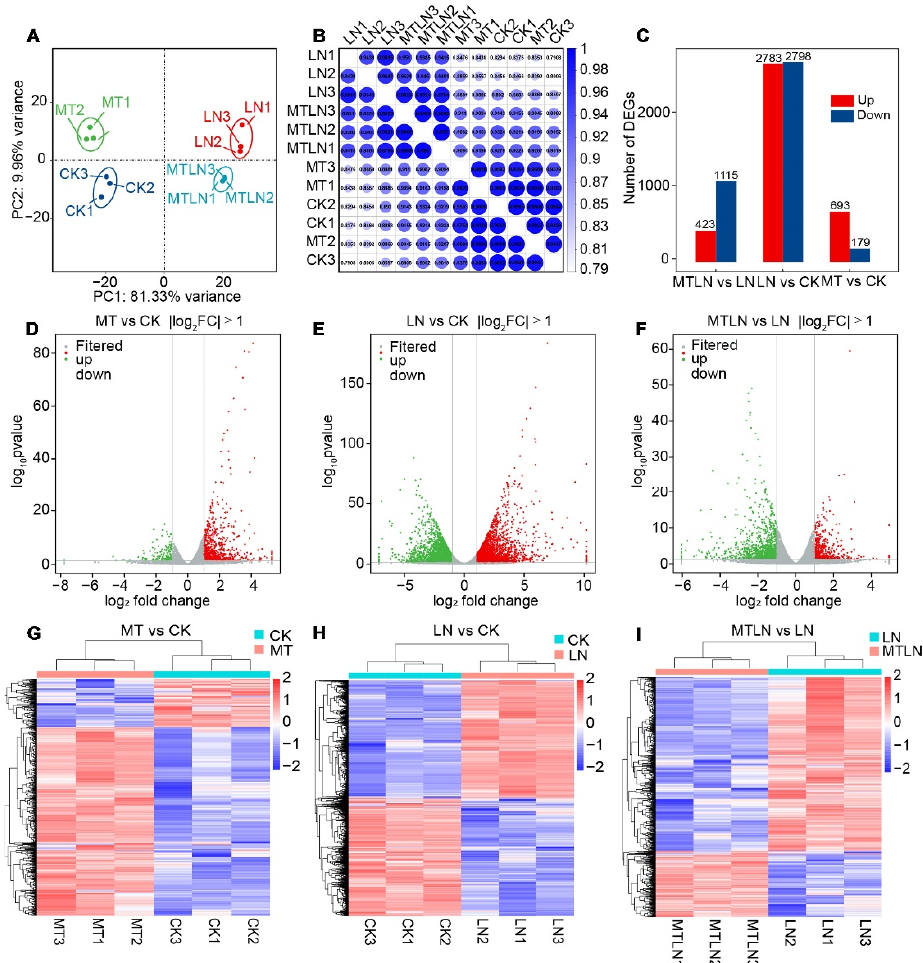
Figure 5. Analysis of differentially expressed genes (DEGs) of melatonin-treated and untreated tomato plants subjected to low night temperature. Principal component analysis (PCA) ( A ); heat diagram of correlation coefficient ( B ); the number of DEGs ( C ); volcano plot of DEGs between MT and CK ( D ); volcano plot of DEGs between LN and CK ( E ); volcano plot of DEGs between MTLN and LN ( F ); cluster heat map of DEGs between MT and CK ( G ); cluster heat map of DEGs between LN and CK ( H ); cluster heat map of DEGs between MTLN and LN ( I ).